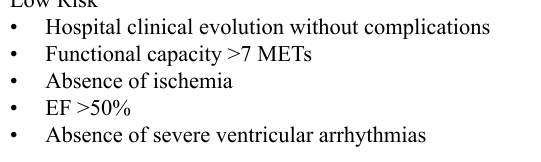
Chart 8A. ESC criteria for risk stratification of events during the year to participate in a cardiac rehabilitation program. Low Risk Hospital clinical evolution without